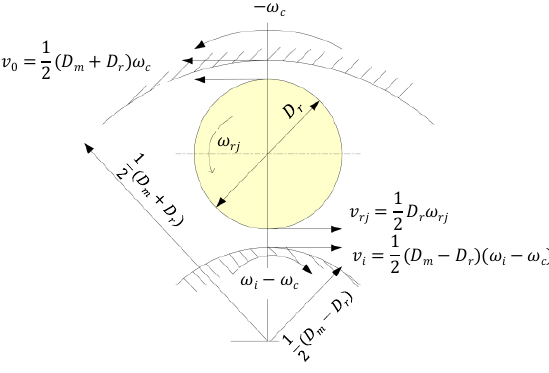
Figure 1. Kinematics model.